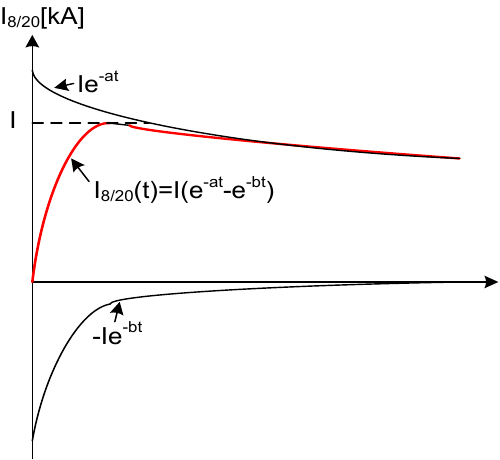
Fig. 2. The exponential form of the current impulse caused by atmospheric discharge